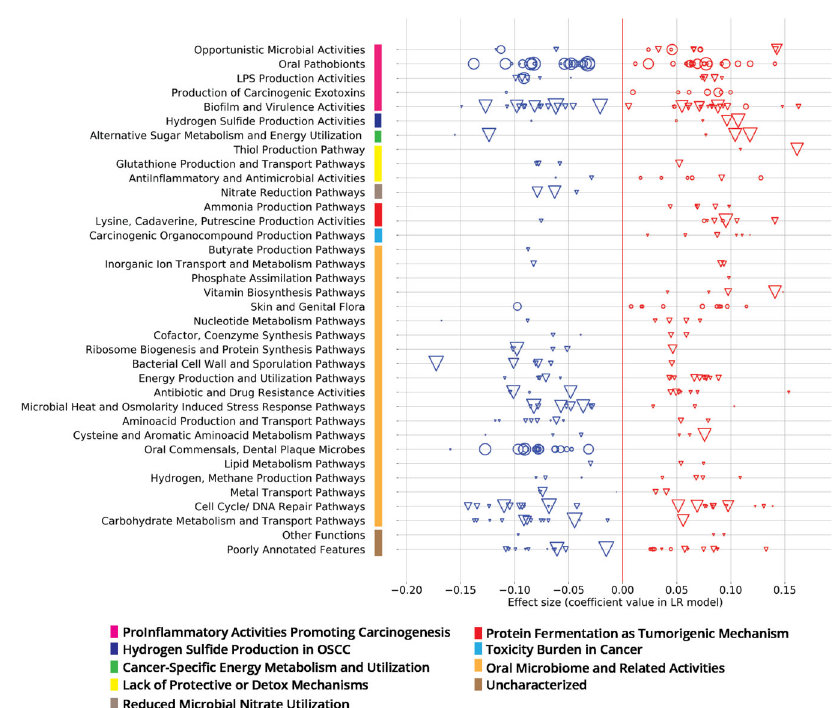
Fig. 3 Oral metatranscriptomic signature from the ML classi fi er trained with Cohort A from Table 1. Effect sizes (coef fi cient values within the classi fi cation model) of 101 active species (circles) and 247 active KOs (triangles), grouped into curated Viome Functional Categories (VFC), see ‘ Supplementary Note 4 ’ section of the Supplementary Material; sizes of circles or triangles are proportional to the CLR median difference in expression level between cases and